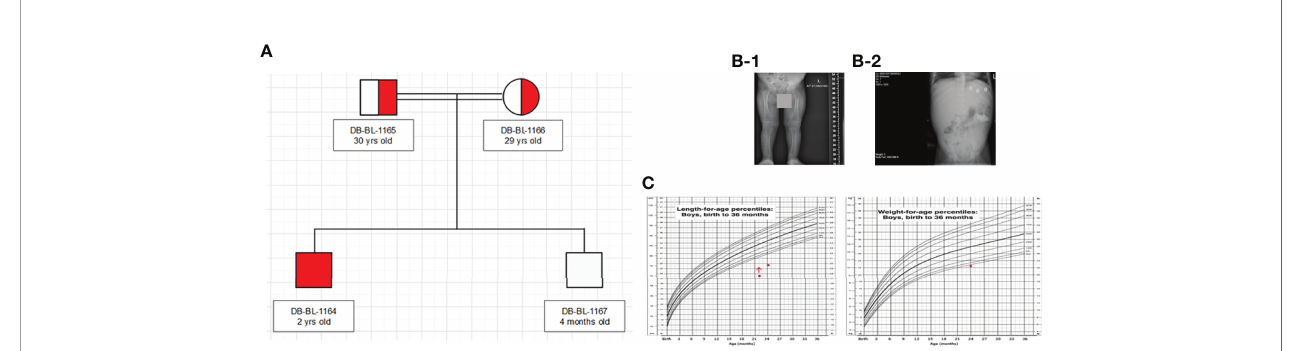
FIGURE 1 | Clinical characteristics of patient: (A) Family Pedigree (B) Radiological fi ndings (x-ray showed rickets (1), and hepatomegaly (2). (C) Growth charts (According to CDC length chart, patient has short stature (dot) responding to growth hormone (red arrow), and underweight